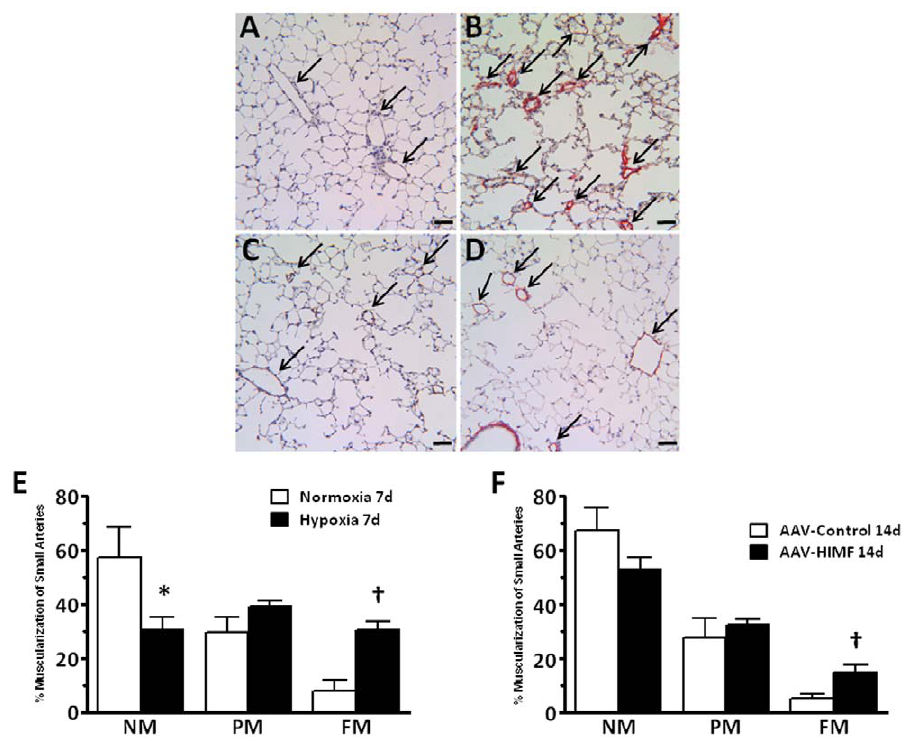
Figure 4. Both chronic hypoxia and pulmonary HIMF gene transfer induce pulmonary vascular remodeling. A–D: Paraffin-embedded lung sections were double-stained with antibodies to von Willebrand factor (black) and a -smooth muscle actin (red). Arrows indicate small pulmonary vessels. Scale bar: 50 m m. E, F: Percent muscularization of small pulmonary arteries in mouse lungs. NM, non-muscularized; PM, partially muscularized; FM, fully muscularized. *Significantly decreased vs. control at P , 0.05. { Significantly increased vs. control at P , 0.05.